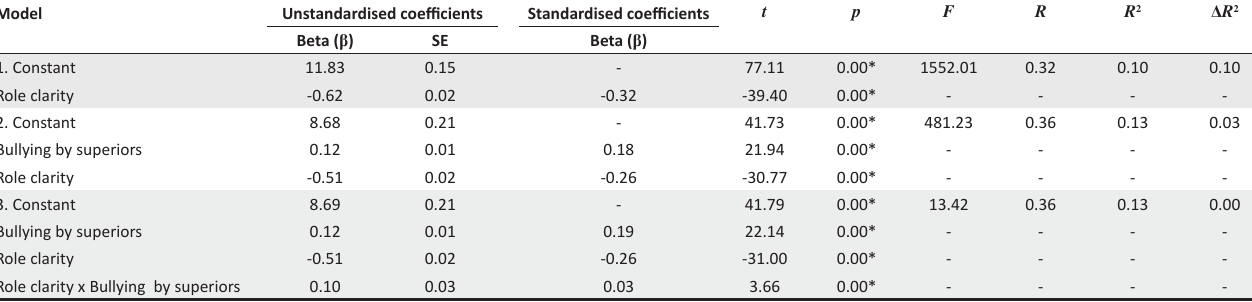
TABLE 4: Hierarchical regression analysis (role clarity) with turnover intention as dependent variable. Model